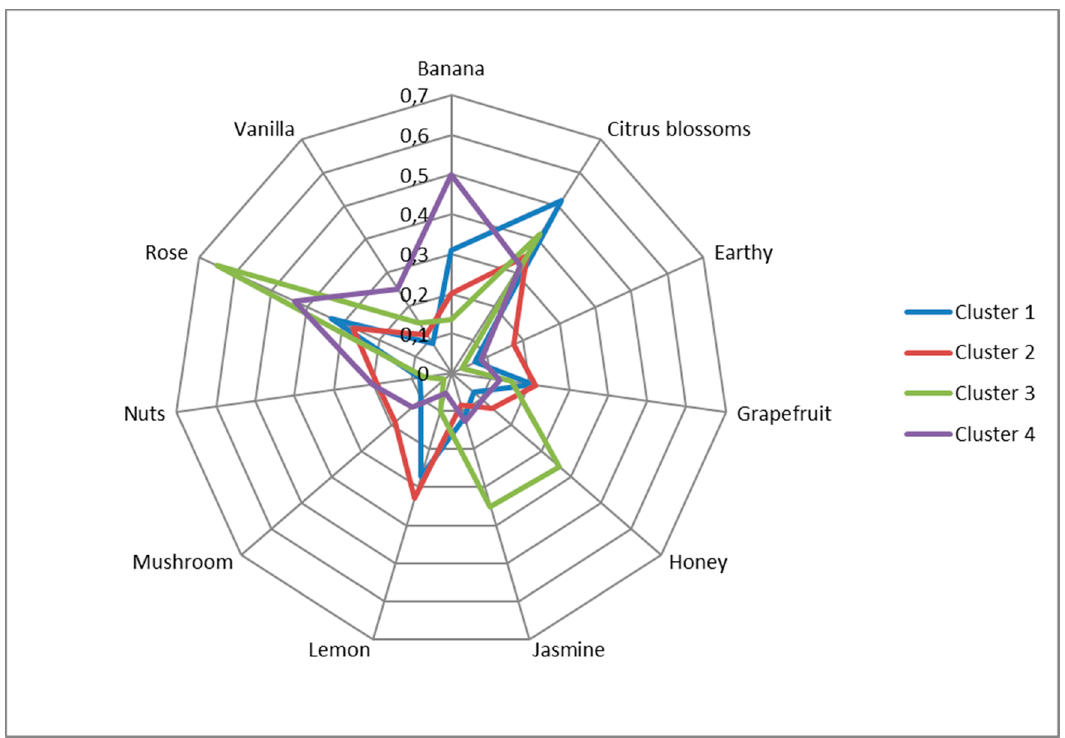
Figure 4. Spider diagram with the average citation proportion of the most cited attributes for each Figure4. cluster.